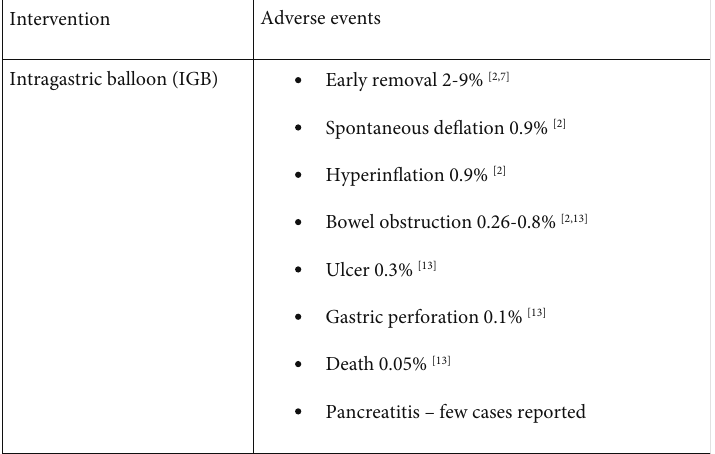
Figure 4: Side-e ff ect pro fi les of